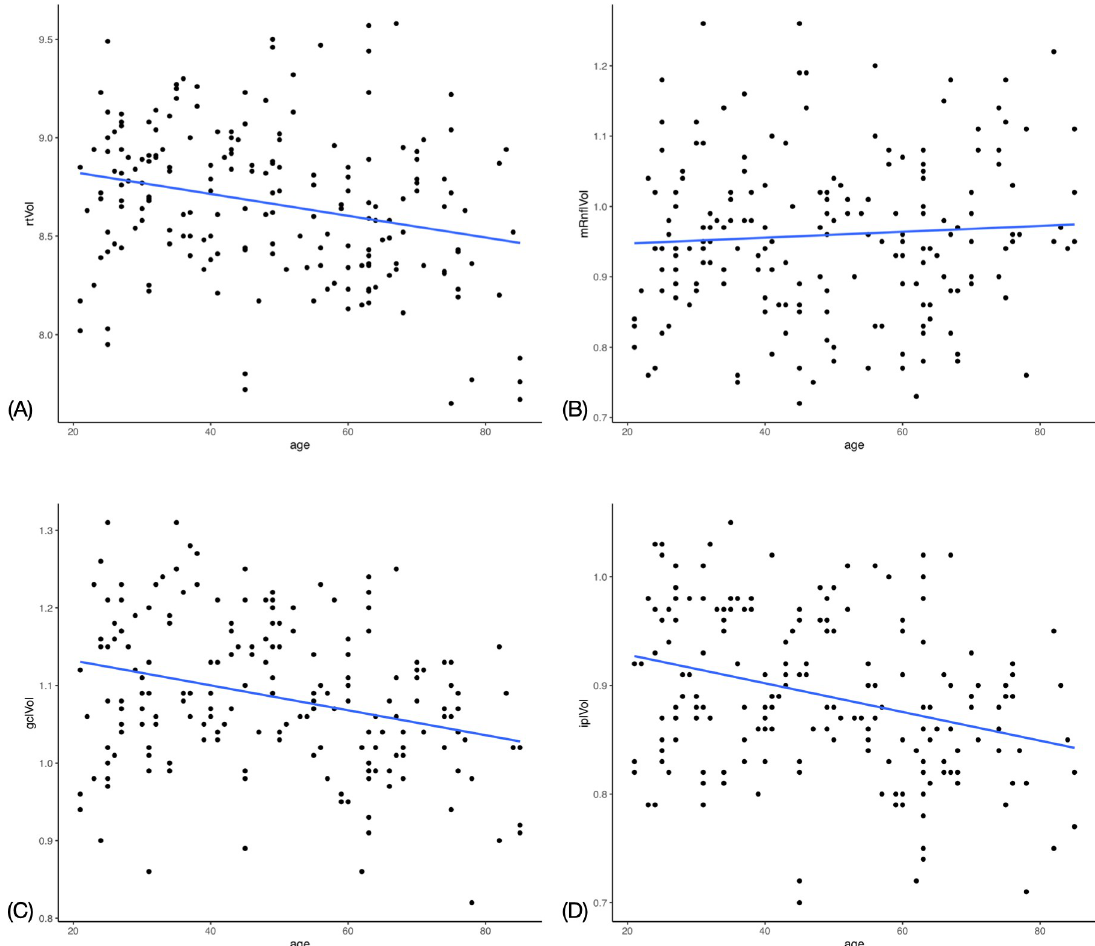
Fig 3. Scatter plot with trend line for macular optical coherence tomography measurements against age. (A) Total retinal volume. (B) Retinal nerve fibre layer volume. (C) Ganglion cell layer volume. (D) Inner plexiform layer volume.